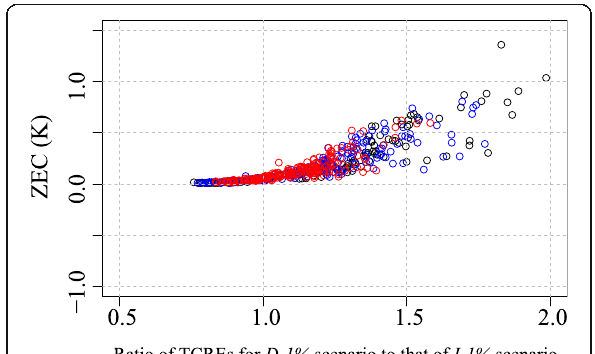
Fig. 5 The relationship between the ZEC and the scenario dependence of the TCRE. The ZEC is presented at the peak temperature after the cessation of CO 2 emissions. Ratio of TCREs for D - 1 % (starting from a non-equilibrium state) to that of I - 1 % scenarios is used as an indicator of the scenario dependence. The red, blue, and black circles indicate members with weights of > 0.5, 0.1 – 0.5, and < 0.1, respectively